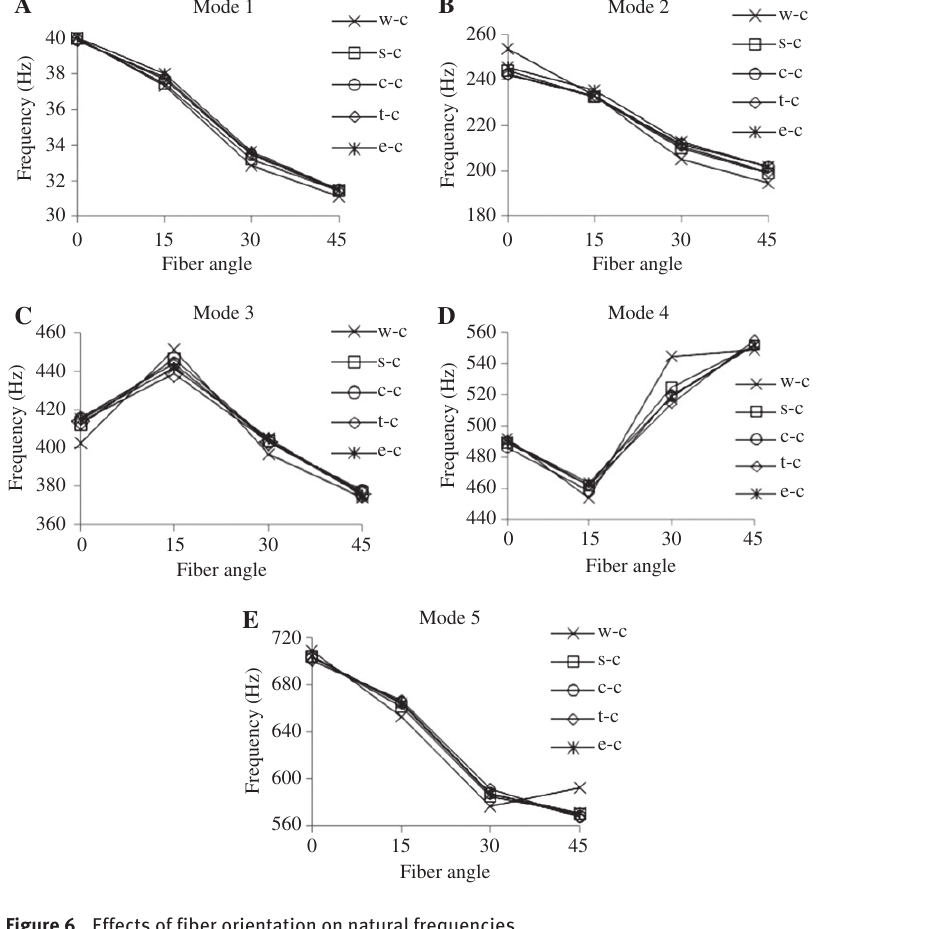
Figure 6 Effects of fiber orientation on natural frequencies.